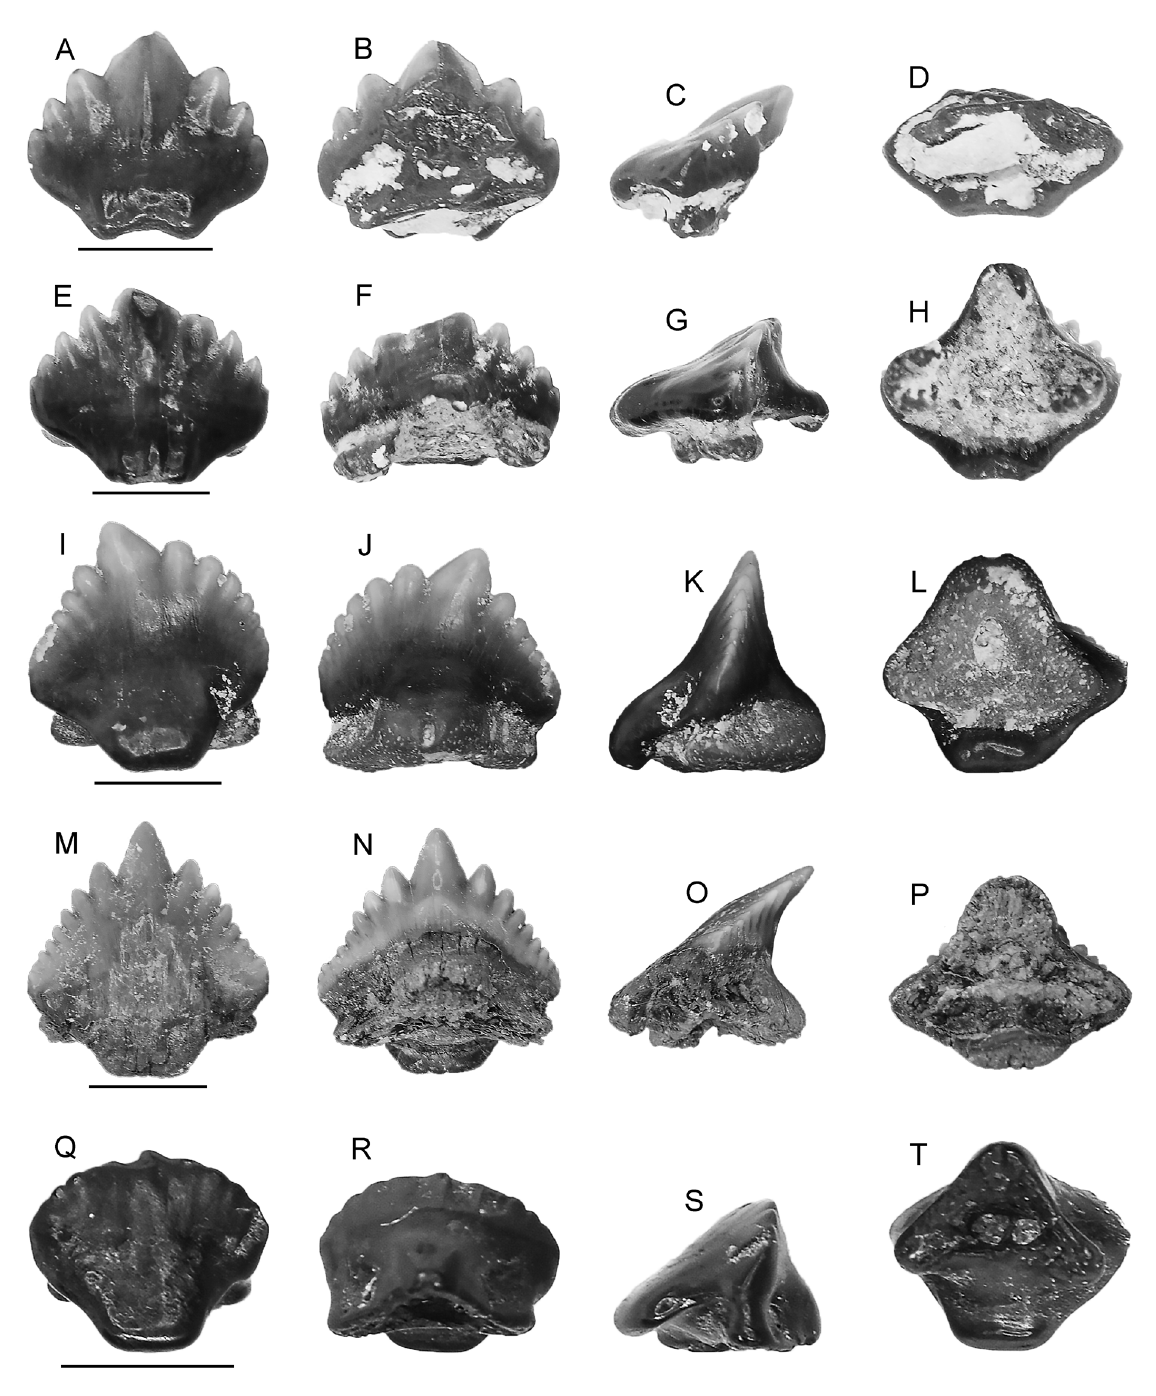
Fig. 7. Ginglymostomatidae Gill, 1862, teeth. A – D . Ginglymostoma maroccanum Noubhani